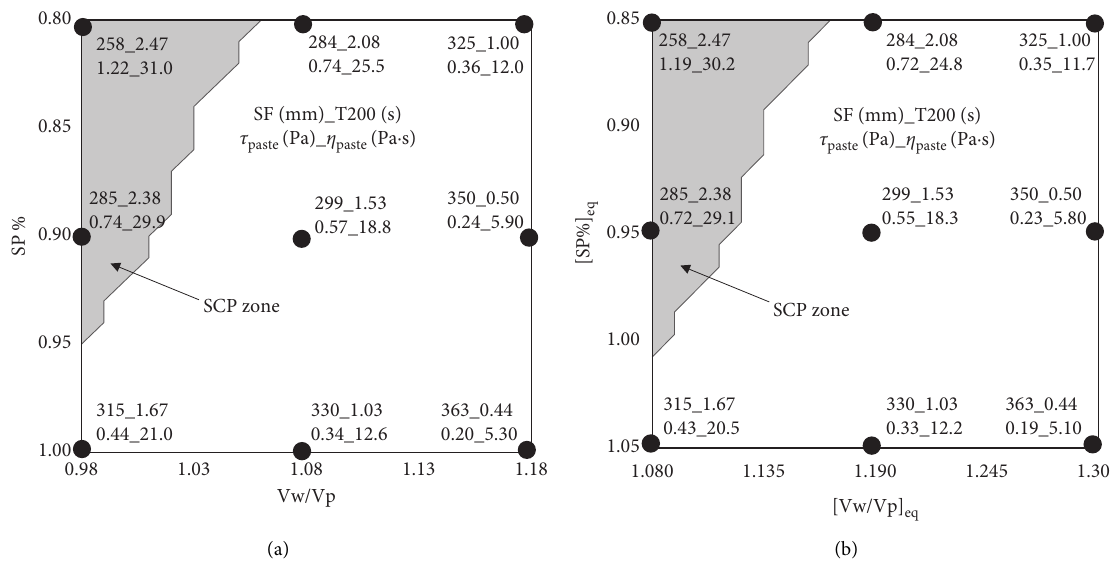
Figure 6: Results of the mini-SF tests on pastes with cement and FA as powder (a) before equivalence; (b) after equivalence.